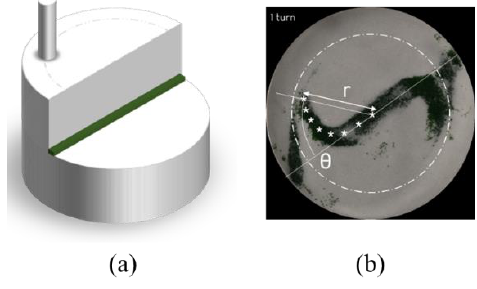
Fig. 6: (a) Illustration of the experimental protocol showing where the thin bar of large (green) particles is deposited (b) Deformed bar after one revolution